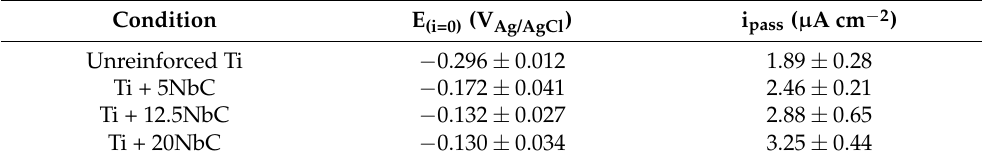
Table 2. Average values of corrosion potential (E (i=0) ) and passivation current density (i pass ).